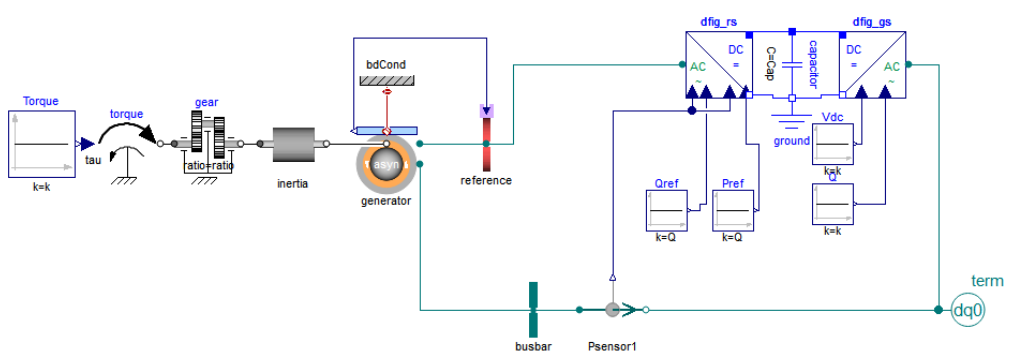
Figure A9. Modelica’s ddouble-fed induction generator (DFIG) model.